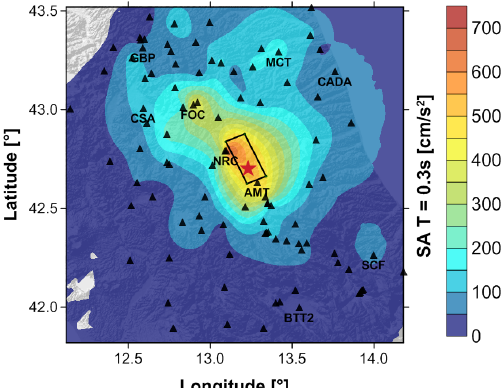
Figure 4 . Map of interpolated horizontal spectral acceleration (T = 0.3s).